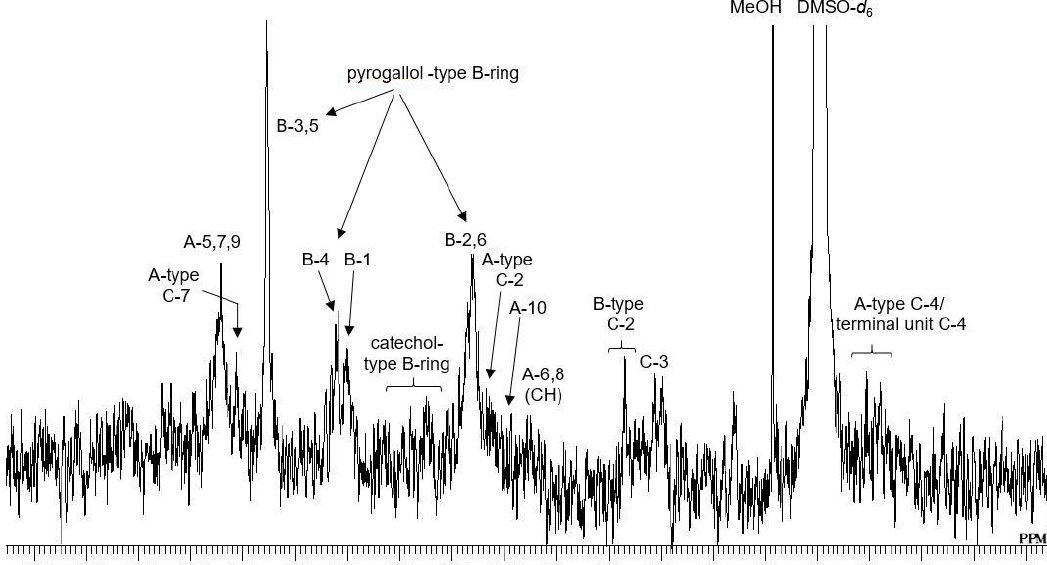
Figure 2. 13 C-NMR spectrum of the proanthocyanidin oligomers from E. sinica , measured at 100 MHz in DMSO -d 6 .